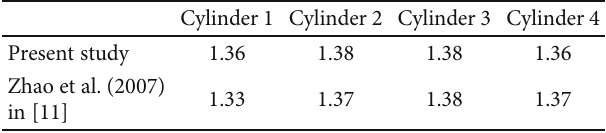
Table 1: Comparison of the simulated maximum run-up to the wave height ratio with Zhao et al. (2007) in [11] for a diamond